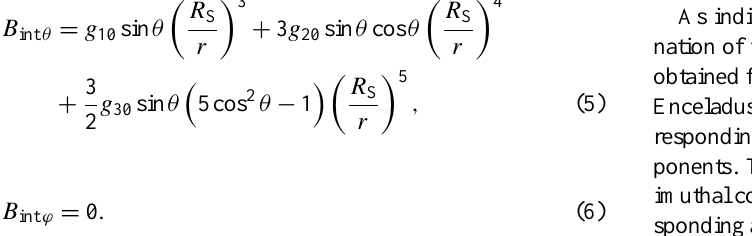
B int θ = g 10 sin